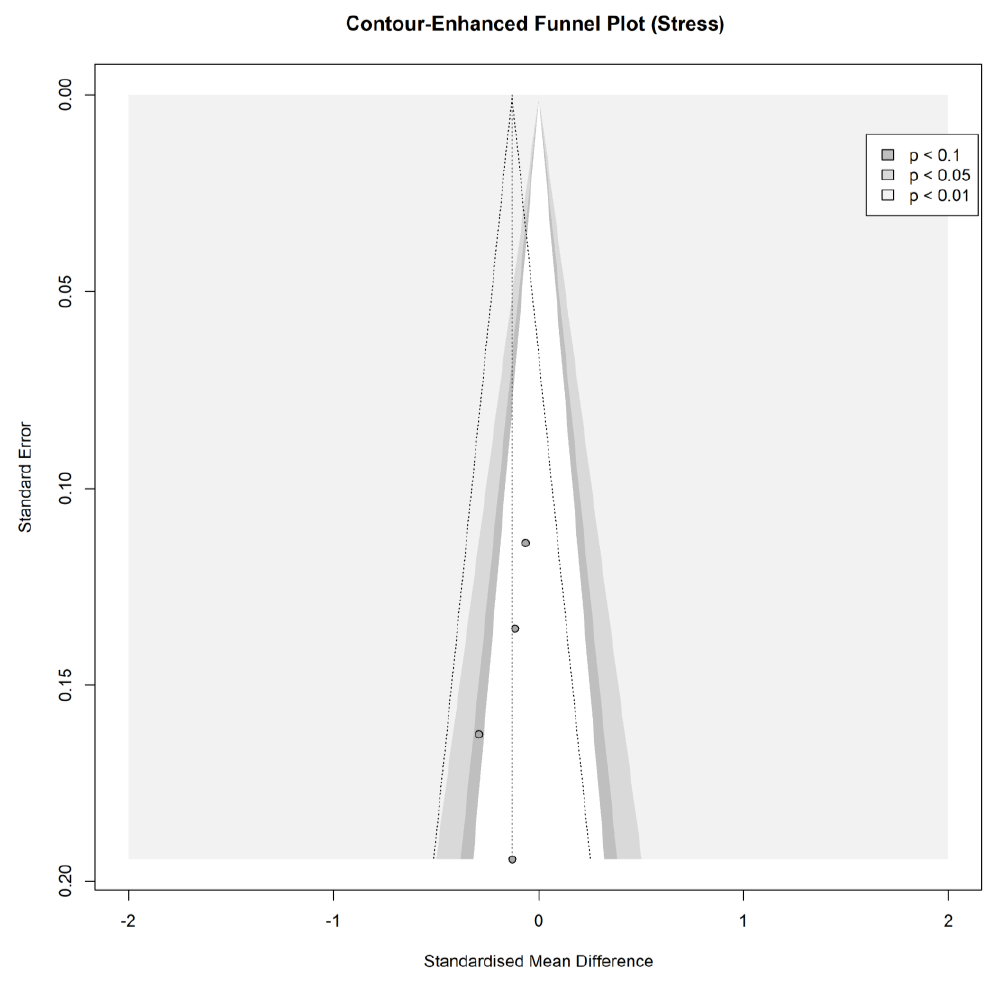
Figure A19. Contour-enhanced funnel plot of all the studies.